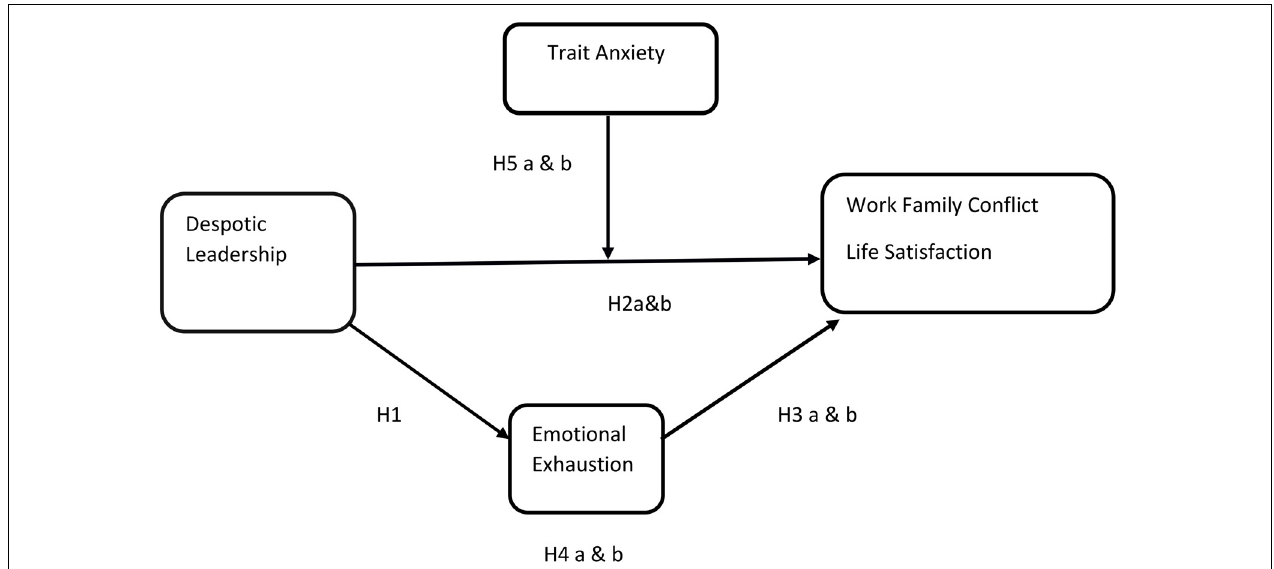
FIGURE 1 | Proposed Theoretical Model.